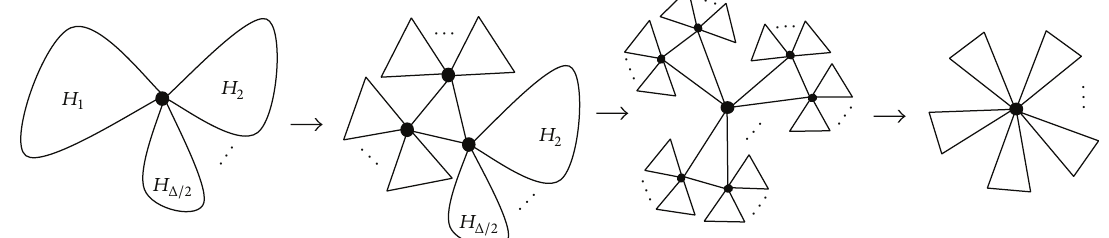
Figure 4: The procedure of